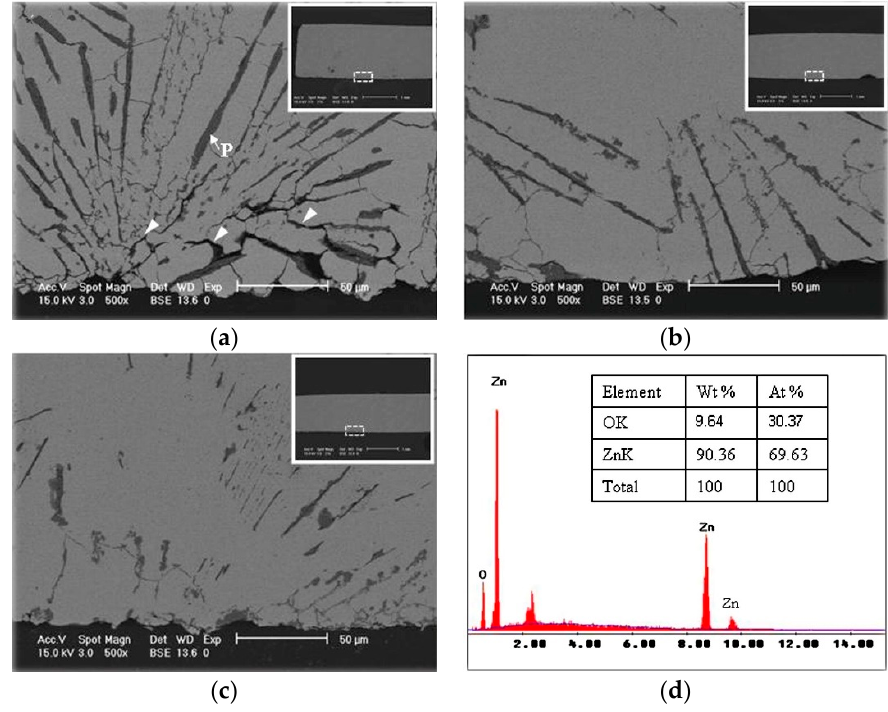
Figure 16. Microstructure of ( a ) SnZnBi, ( b ) SnZnBi–0.5Ag, and ( c ) SnZnBi–0.5Ni solder alloys at 85 °C/85% relative humidity (RH) after exposure for 250 h and ( d ) energy dispersive spectrometer (EDS) analysis of region P in (a) [76].